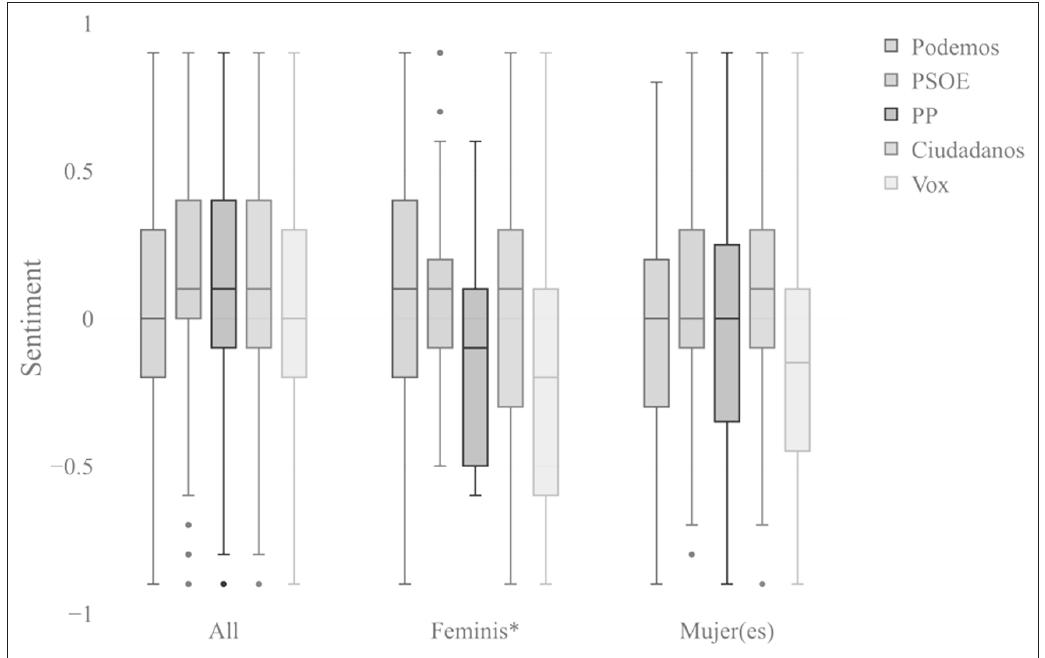
Figure 6: A comparison of party sentiment based on three analyzed corpuses: all tweets, tweets that include mujer and mujeres (woman/women), and tweets that include feminista/feminismo . Note that the dots represent